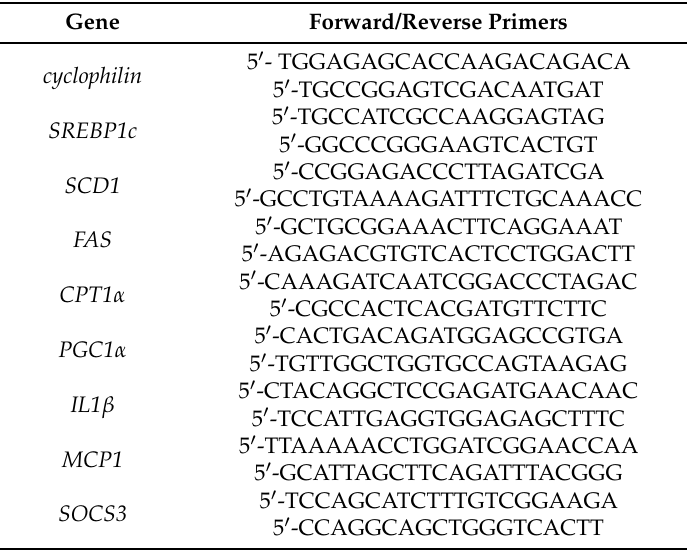
Table 1. Primers used for quantitative real-time